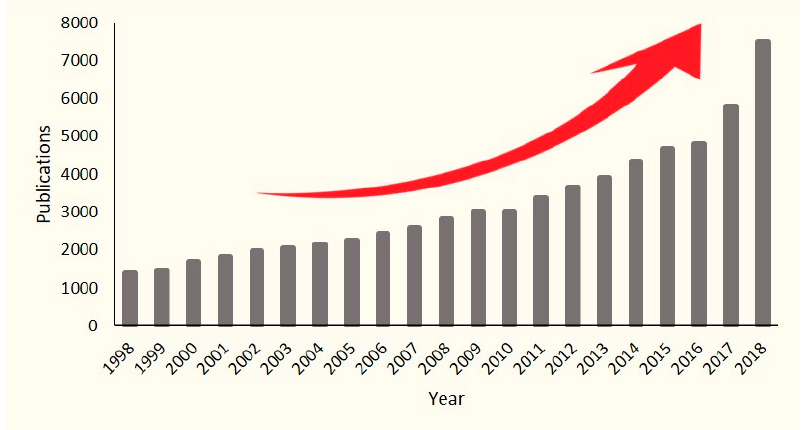
Figure 3. The number of research articles available in PubMed by searching “Natural Antimicrobial” from 1998 to 2018. The red arrow represents a growing trend.